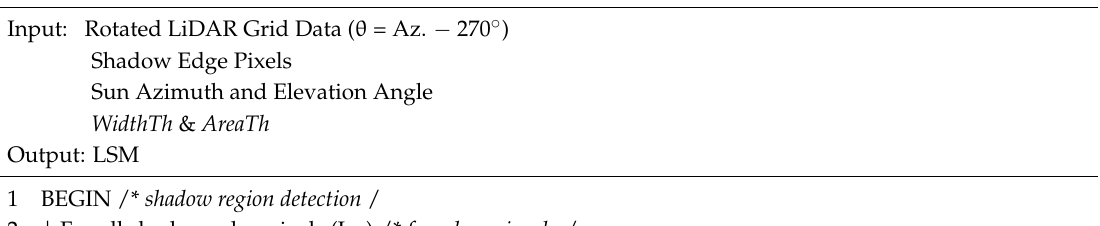
Algorithm 2 Shadow Extraction in LiDAR